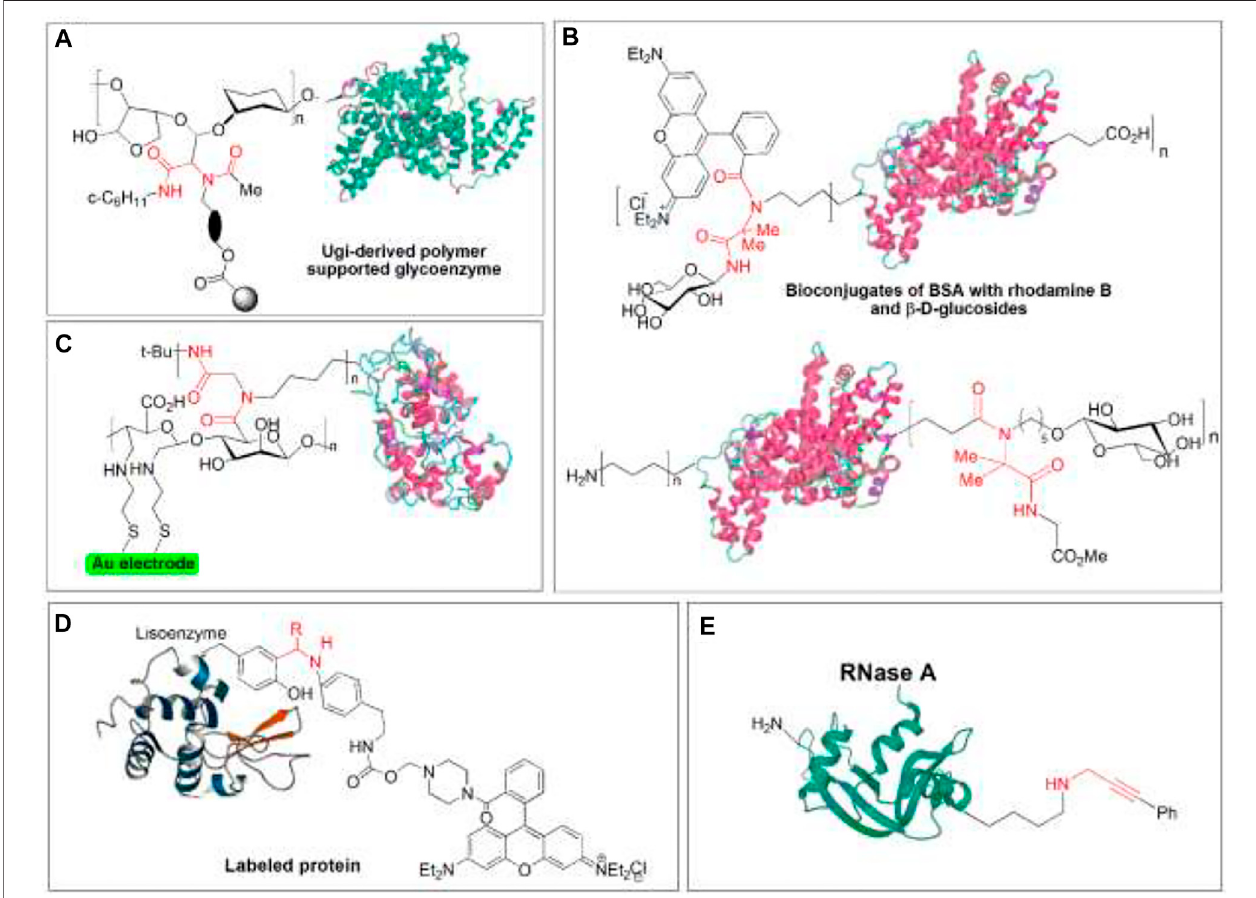
FIGURE 14 | Protein immobilization, labeling, and glycoconjugate (A) Ugi-derived polymer-supported glycoenzyme; (B) fi nal products from multicomponent conjugation (MCC) to polymeric support (see Panel (A) ) and fl uorescent label (rhodamine B) and carbohydrate ( β -D-glucosides) using Ugi reaction; (C) multicomponent immobilization(MCI)ofhorseradishperoxidase(HRP)onapolysaccharide-coatedgoldelectrode; (D) site-selectiveproteinlabelingatTyrresiduebyMannichtypeMCC; (E) . Site-selective protein labeling at only one Lys residue by Cu-catalyzed A3 coupling MCC. The most important covalent bond between entities is highlighted in